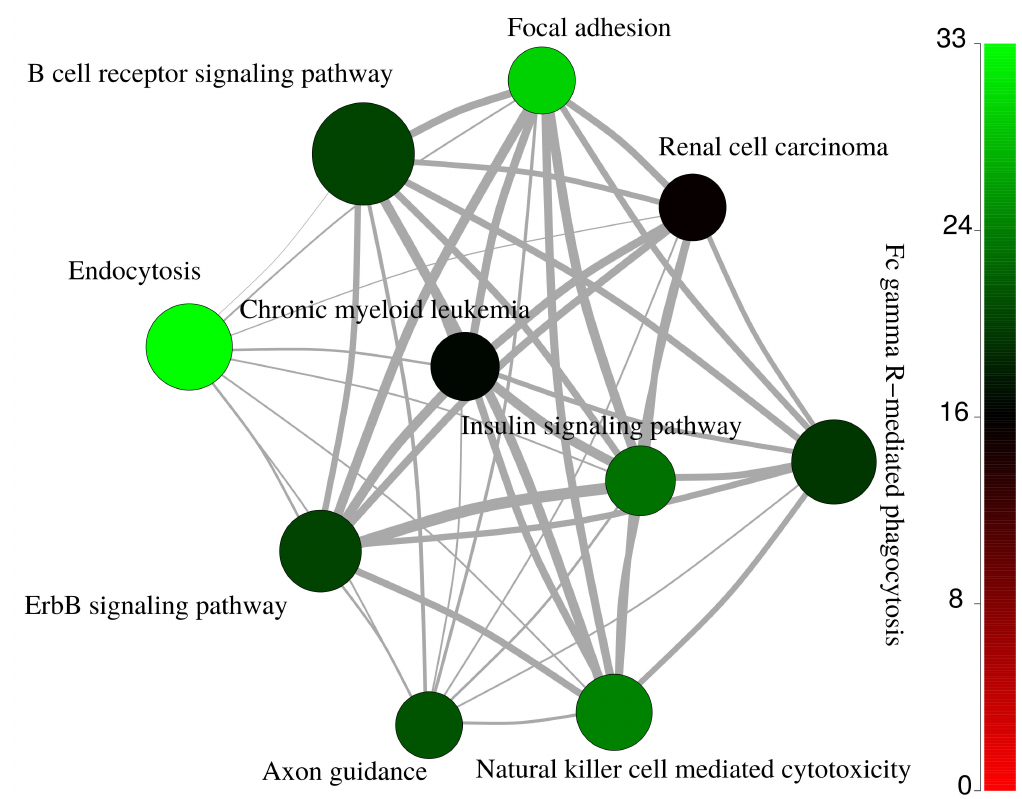
Figure A4. Interconnection of the most enriched KEGG pathways for regulated EVs proteins. The color coding of the nodes indicates the number of proteins regulated for each category. The size of the nodes reflects log 10 of enrichment p value. The thickness of the edges reflects the number of shared regulated proteins between the KEGG pathways (ranging from 1 to 18